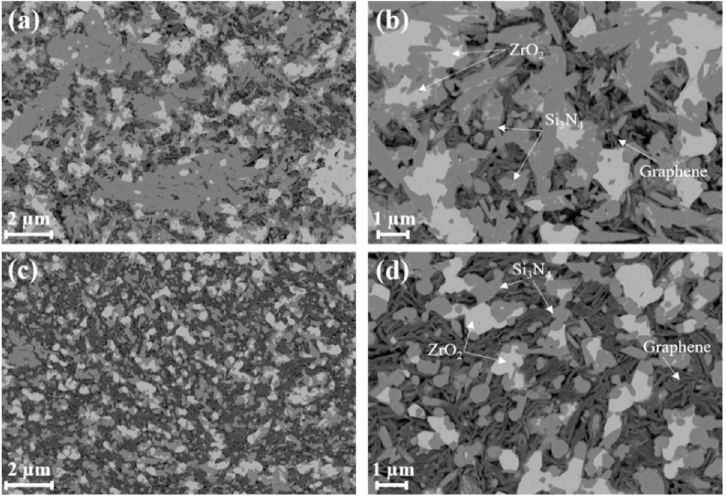
Figure 2. SEM images of the sintered silicon nitride–zirconia–graphene composite. ( a , b ) With 5 wt.% MLG; ( c , d ) with 30 wt.% MLG. Table 1. Density and porosity of synthesized silicon nitride–zirconia–graphene